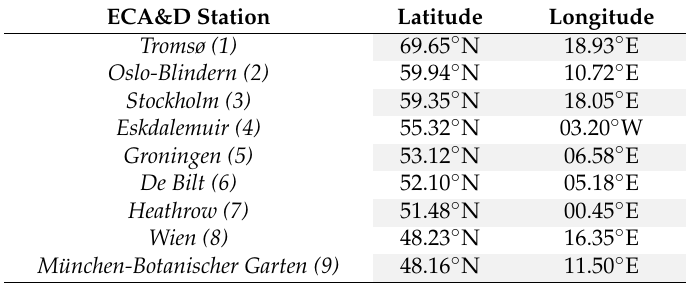
Figure 1. Geographical distribution of the ECA&D stations used in this study. The numbers are listed in Table 3. Table 3. European Climate Assessment & Dataset (ECA&D) stations used in this study along with their